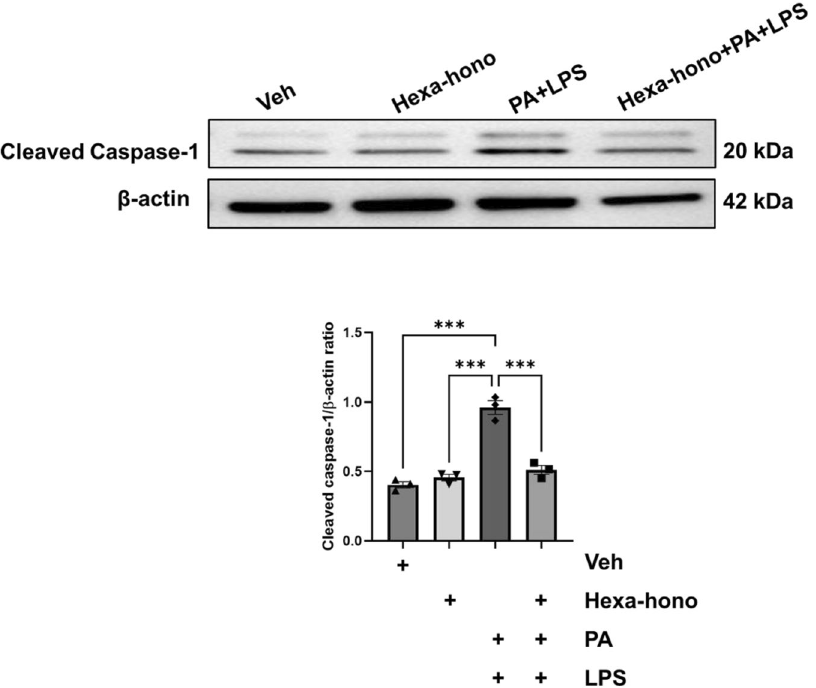
caspase-1 band density normalized to β-actin. The uncropped Western blot images of Fig. 5 have been provided in the supplementary file. Both protein of interest and loading control were run on a single membrane. Data are the mean ± SEM from three independent experiments. *** P < 0.001; (2-way